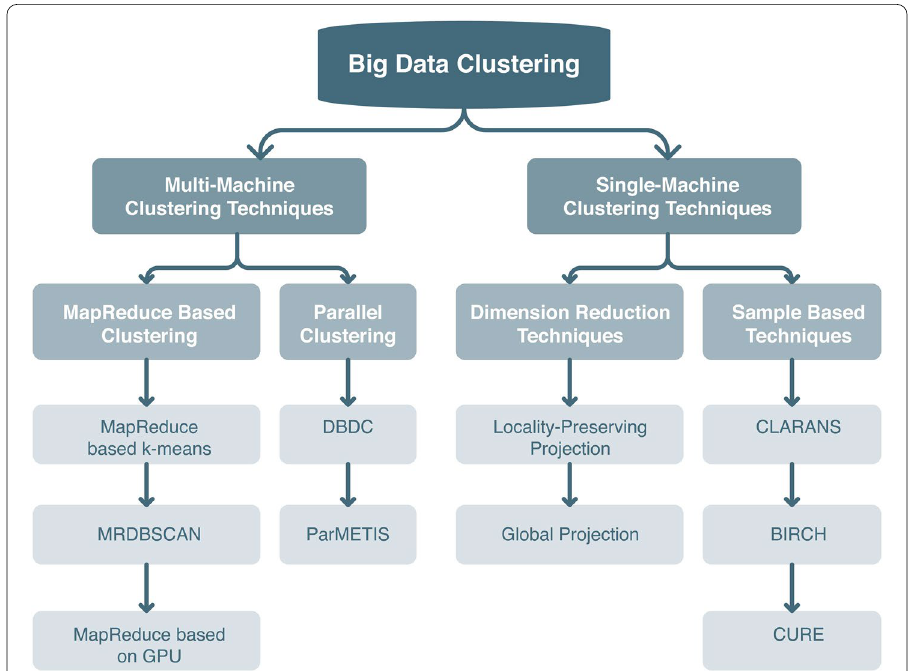
Fig. 2 Classification of big data clustering algorithms